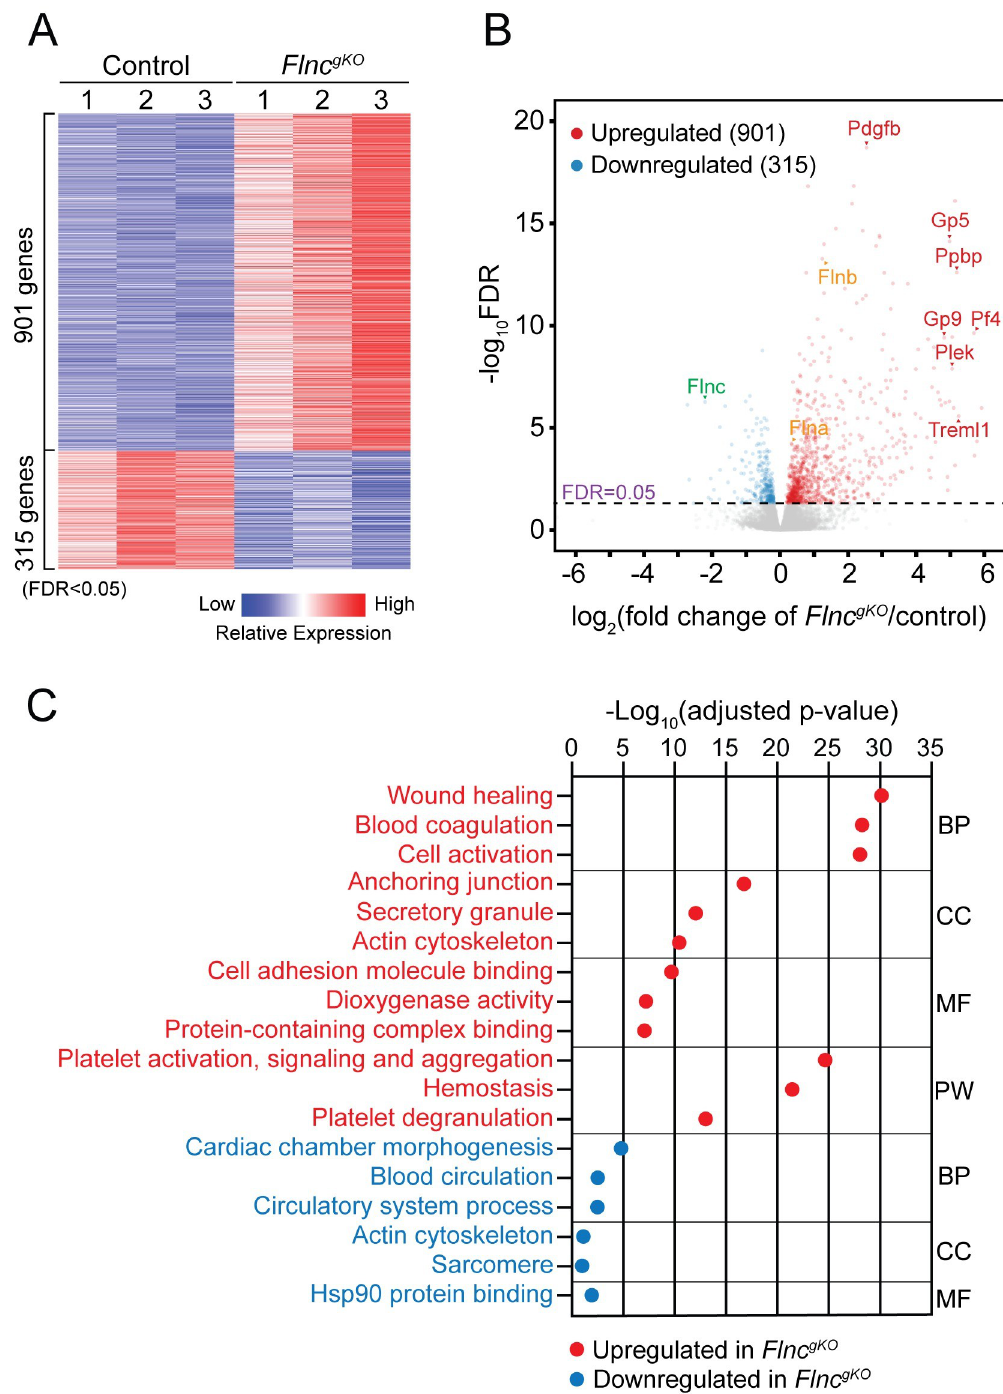
Fig 3. Wound healing and blood coagulation pathways were activated in Flnc gKO . ( A ) Heatmap showing gene expression changes in E9.5 control and Flnc gKO hearts (n = 3 per group). ( B ) Volcano plot of differentially expressed genes (DEGs) [false discovery rate (FDR) < 0.05)] in E9.5 Flnc gKO hearts compared with littermate controls. Notable DEGs are indicated. ( C ) Gene ontology analysis of differentially expressed genes of Flnc gKO hearts compared with littermate controls at E9.5. BP, biological process; CC, cellular component; MF, molecular function; PW, KEGG pathway.